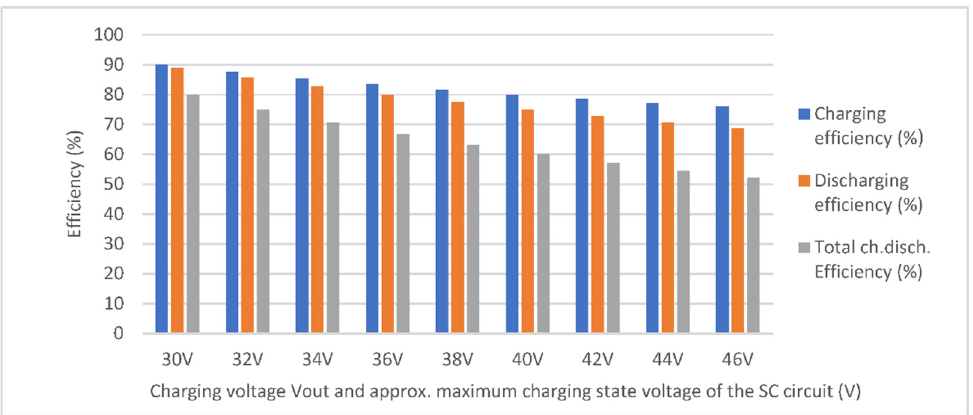
Figure 8. Charging, discharging, and total charging/discharging efficiency comparative diagrams of the SC circuit with 24 V initial voltage and various charging voltages. the SC circuit with 24 V initial voltage and various charging